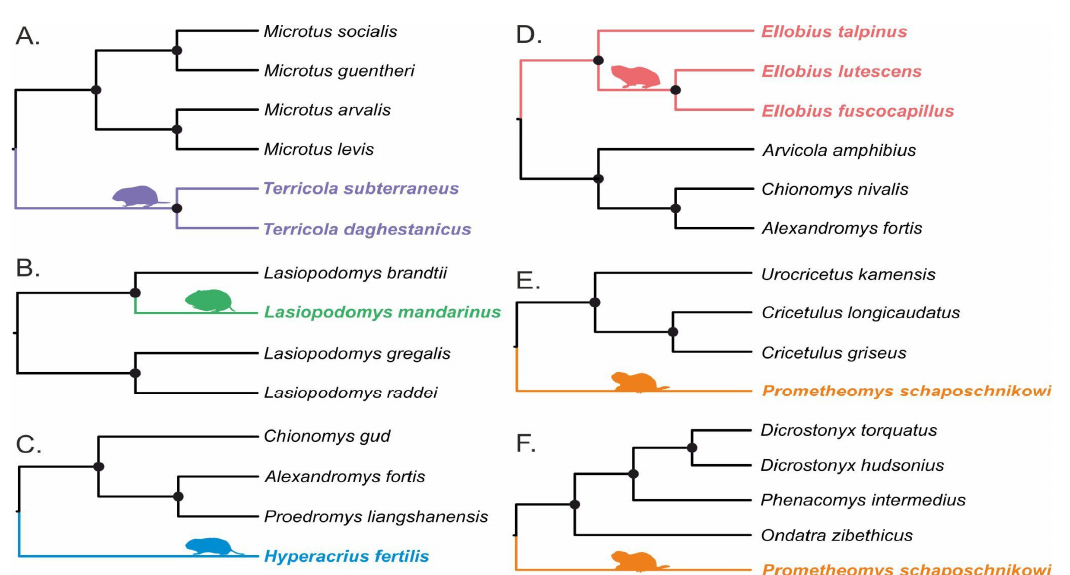
Figure 1. Trees used for tracing signatures of the selection pressures on the independent subterranean vole species. Separate trees show the phylogenetic relationship of subterranean voles (colored) and their closest aboveground relatives: Terricola species ( A ), L. mandarinus ( B ), H. fertilis ( C ), Ellobius species ( D ), and P. schaposchnikowi ( E ) comparing with aboveground representatives of Cricetinae subfamily, and ( F ) comparing with aboveground representatives of Arvicolinae subfamily, 1st radiation). Fifty-percent majority rule consensus trees from Bayesian inference analysis are given. Black circles show nodes with Bayesian posterior probabilities above 0.99.